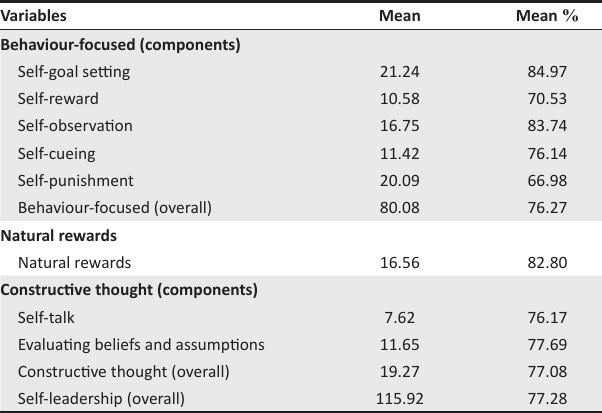
TABLE 2: Descriptive statistics of